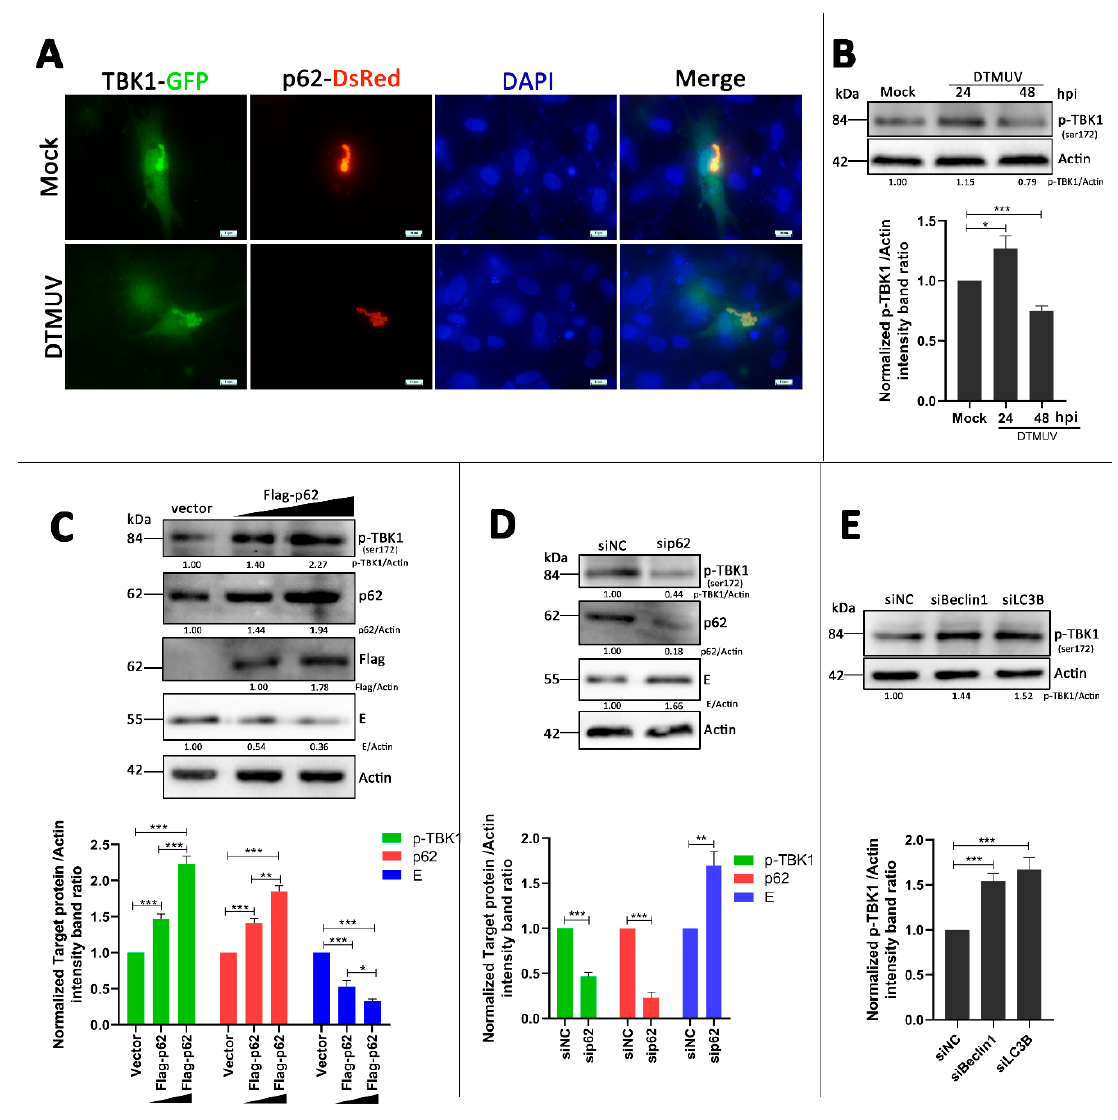
Figure7. TBK1isatargetofp62modulatinginnateimmuneresponses. ( A )DEFcellswereco-transfected with GFP-TBK1 and DsRed-p62 plasmids for 24 h prior to experiment. Cells were then mock-infected or infected with DTMUV at an MOI of 1 for 24 hpi. Cells were fixed and imaged for GFP and DsRed fluorescence. Images shown were representative of three independent experiments. ( B ) DEF cells were mock-infected or infected with DTMUV at an MOI of 1 for 24 and 48 h. Samples were harvested for Western blot analysis and immunoblotted for p-TBK1 and β -actin. The ratio of p-TBK1 to β -actin was normalized to control conditions in mock-infected cells. ( C ) DEF cells were treated as described in Figure 6A, and cells were harvested for Western blot analysis and immunoblotted for p-TBK1, p62, Flag, DTMUV-E, and β -actin. The ratios of targeting proteins to β -actin were normalized to control. ( D ) DEF cells were treated as described in Figure 6E. Then, cells were harvested for Western blot analysis and immunoblotted for p-TBK1, p62, DTMMUV-E, and β -actin. The ratios of targeting proteins to β -actin were normalized to control. ( E ) DEF cells were treated as described in Figure 5C. Then, cells were harvested for Western blot analysis and immunoblotted for phosphorylated TANK-binding kinase 1 (p-TBK1) and β -actin. The ratios of targeting proteins to β -actin were normalized to control. Error bars: Mean ± SD of three independent experiments. Two-tailed Student’s t test; * p < 0.05, ** p < 0.01, *** p <